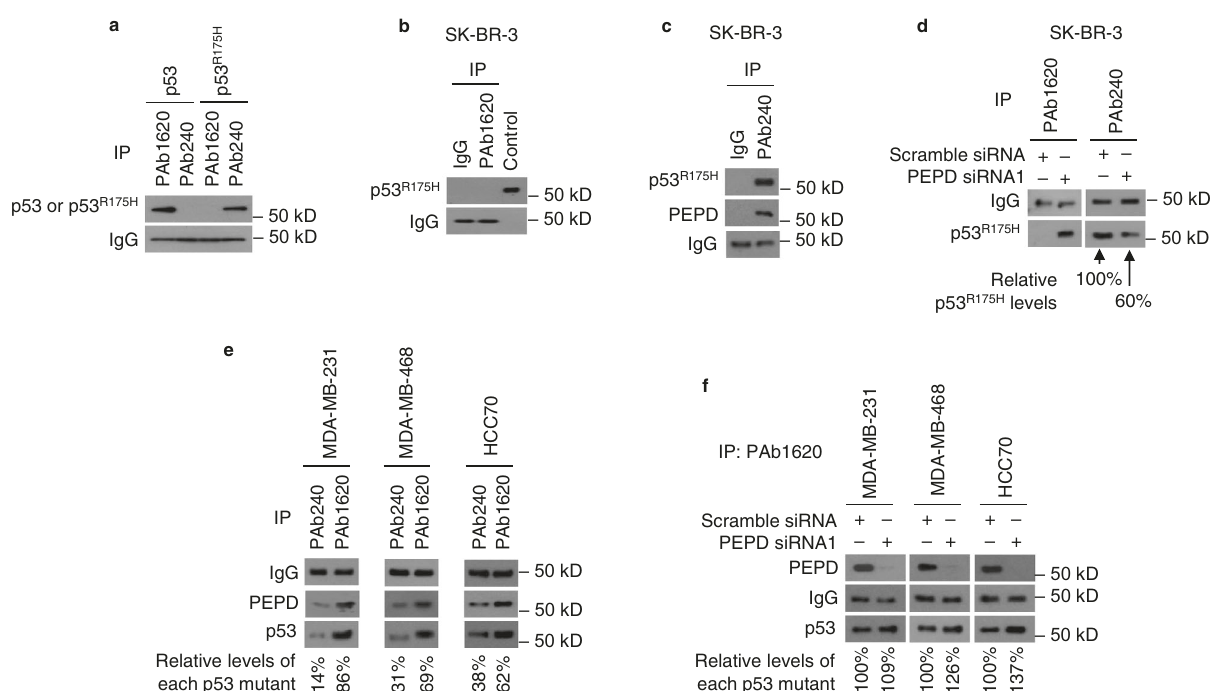
Fig. 8 p53 mutants refold once separated from PEPD. a Recombinant p53 and p53 R175H were subjected to IP by PAb1620 or PAb240, followed by WB analysis of the precipitate for p53 and p53 R175H . b – f WCL of untreated cells in b , c , and e or WCL of cells treated with siRNA (10 nM) for 48 h in d and f were subjected to IP by PAb1620, PAb240, or isotype-matched IgG, followed by WB analysis of the precipitate for p53 mutants and PEPD. A p53- containing sample (WCL of untreated CAL-51 cells) was used as a positive control during WB in b . The relative level of each p53 mutant in d – f was measured by ImageJ.